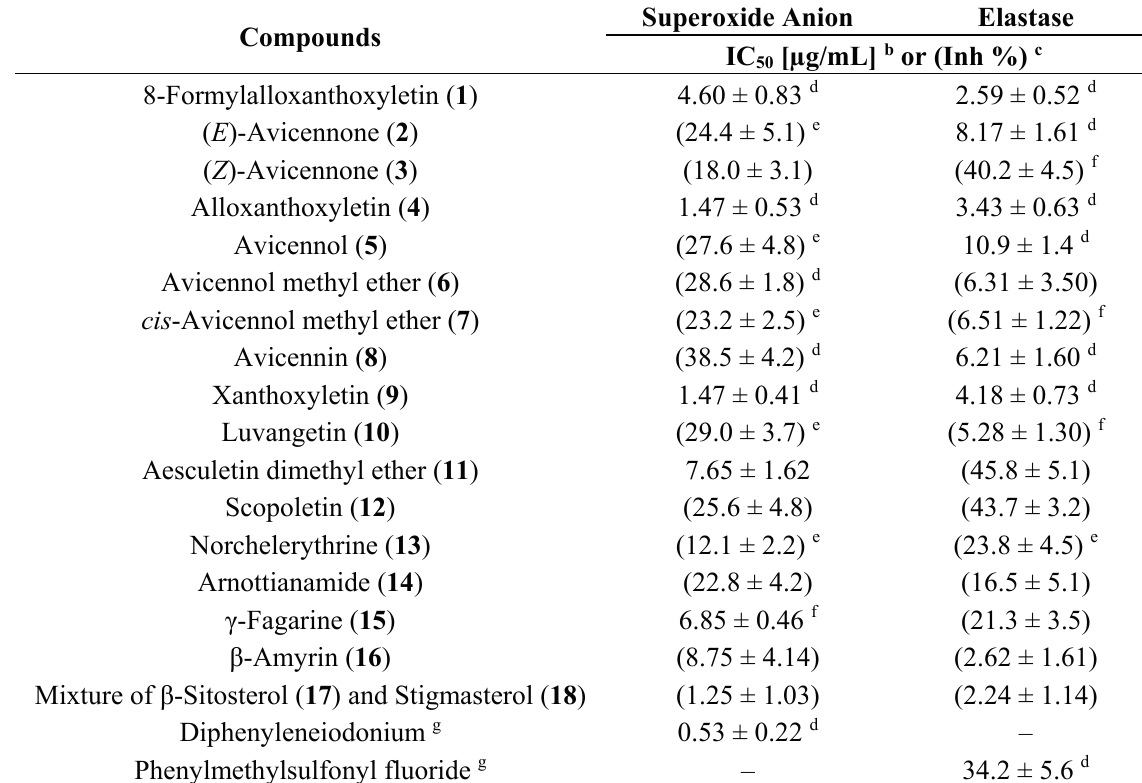
superoxide radical anion generation and elastase release by human neutrophils in response to fMet-Leu-Phe/cytochalasin B a